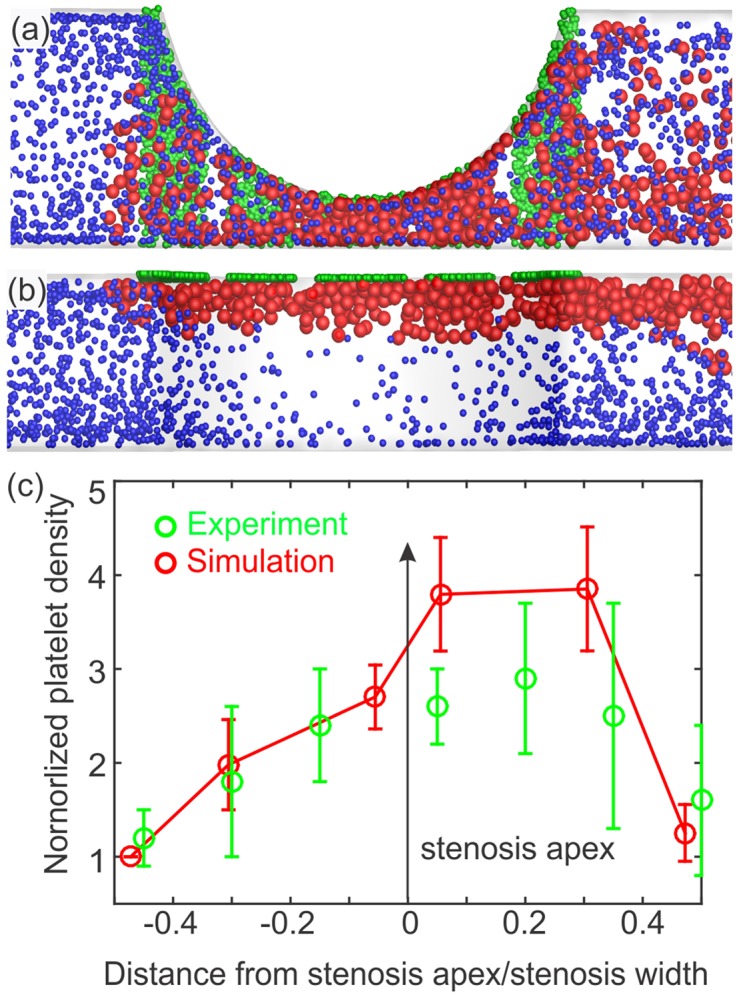
Simulation results for platelet aggregation at high shear rates inside an 80% stenosis, where the undisturbed maximum wall shear rate is 8,000 s−1.(a) View normal to the flow direction, and (b) view from above. Color coding for particles is the same as in Fig 3. (c) Normalized density of adhered platelets throughout the stenosis along the flow direction vs. normalized axial location. The density is normalized by the number of adhered platelets at the inlet, and axial distance is normalized by the length of the stenosis. Simulation results (−□−) are based on the activation delay time τact = 6 ± 3ms, and the error bars are computed based on 5 simulations with the same τact; experimental data (−○−) are extracted from Westein et
al. [14] and plotted for comparison.